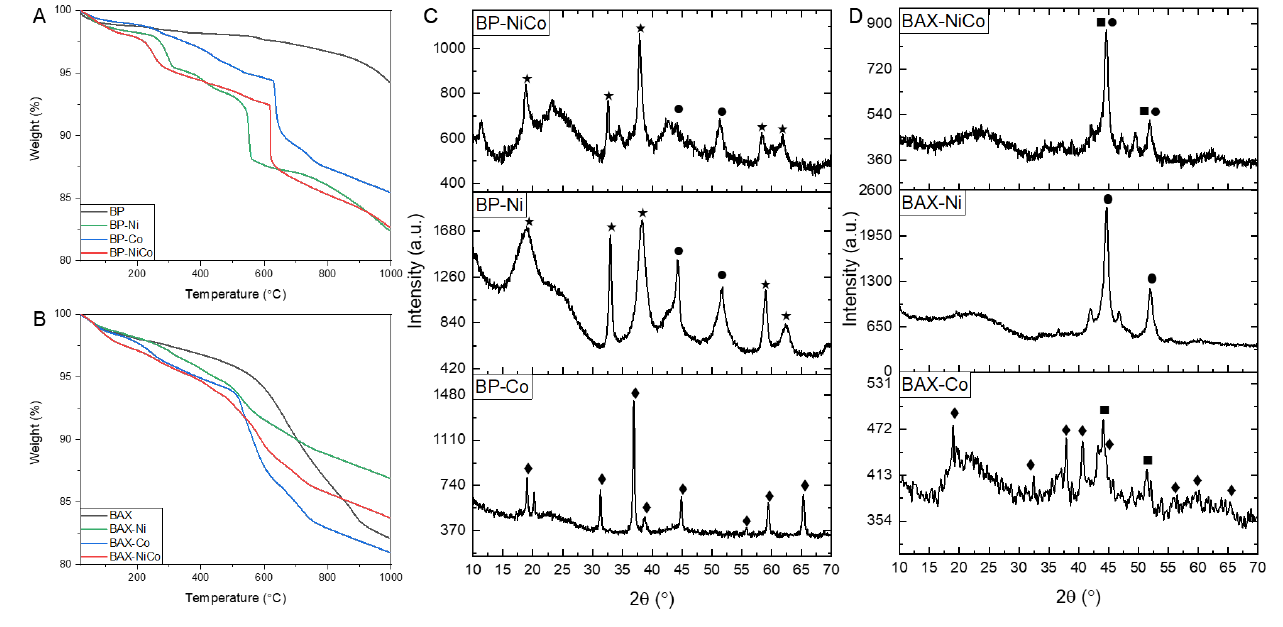
Figure 5. TG curves in argon for the BP series ( A ) and the BAX ones ( B ); XRD of the BP series ( C ) and the BAX ones ( D ); ◼ , ⚫ Co and Ni cubic Fm-3m, respectively, Ni(OH) 2 hexagonal P-3m1, ⧫ Co 3 O 4 cubic Fd-3 m.